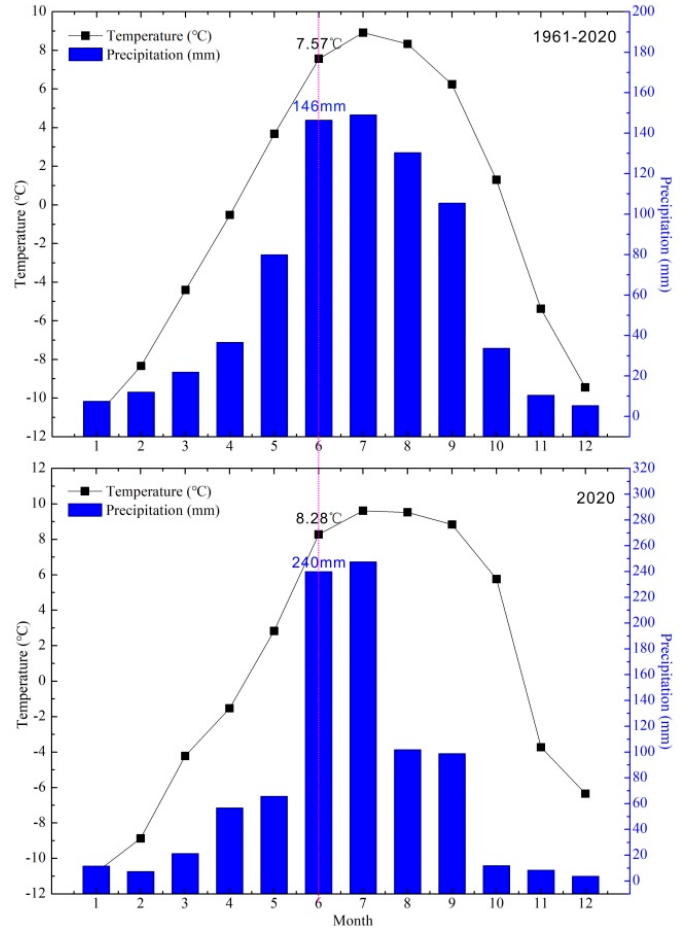
Figure 5. Comparison of average monthly temperature and precipitation of Jiali Station between 1961–2020 and 2020.